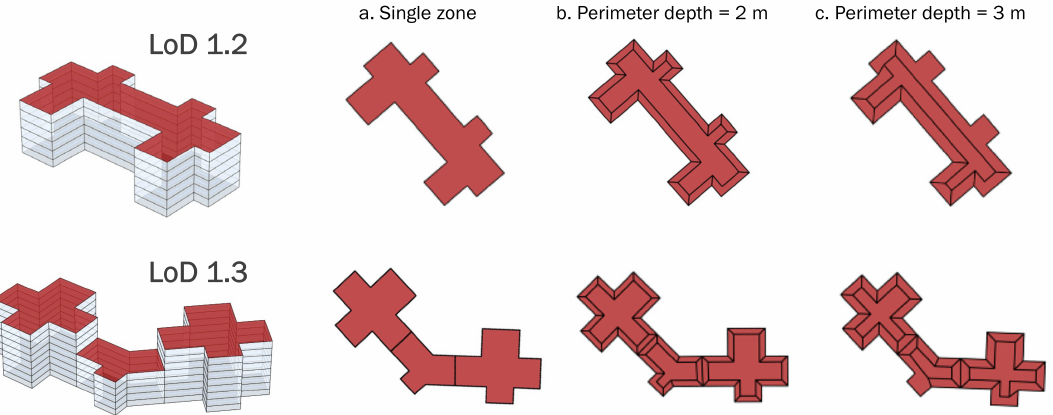
Figure 3. Thermal zoning for two sample buildings—LoD 1.2 (top) and LoD 1.3 (bottom), using three zoning strategies: single zone ( a ), and perimeter/core zoning at 2 m ( b ) and 3 m ( c ) perimeter